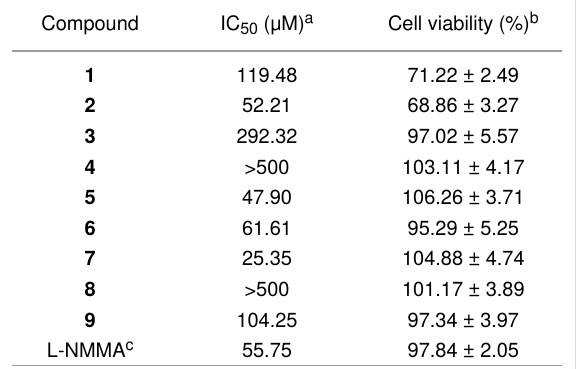
Table 4: Inhibitory effects of compounds 1 – 9 on NO production in LPS-activated BV-2 cells.